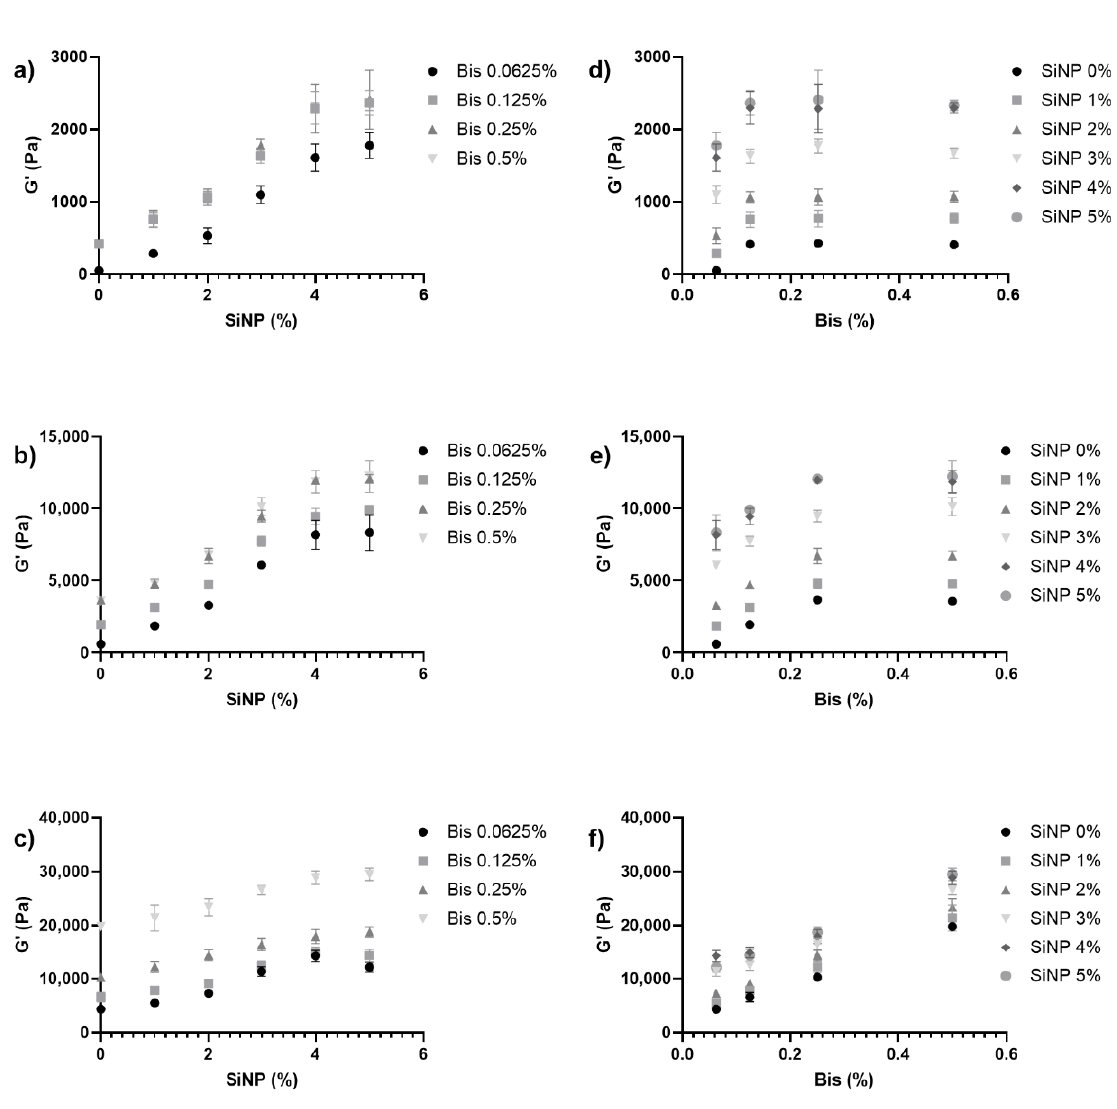
Figure 1. Mechanical properties of the pAAm hydrogels prepared using different concentrations of 4 nm silica nanoparticles, Bis crosslinker, and acrylamide. ( a – c ) Elastic moduli (G’) as a function of silica nanoparticle concentration for hydrogels prepared using different concentrations of the Bis crosslinker —●: 0.0625% Bis, ■ : 0.125% Bis, ▲ : 0.25% Bis, and ▼ : 0.5% Bis and ( a ) 2.5% AAm, ( b ) 5% AAm, or ( c ) 10% AAm. ( d – f ) Elastic moduli (G’) as a function of Bis concentration for hydrogels prepared using different concentrations of nanoparticles —●: 0% SiNP, ■ : 1% SiNP, ▲ : 2% SiNP, ▼ : 3% SiNP, ◆ : 4% SiNP, and ○ : 5% SiNP and ( d ) 2.5% AAm, ( e ) 5% AAm, or ( f ) 10% AAm. N = 3 for each hydrogel preparation.